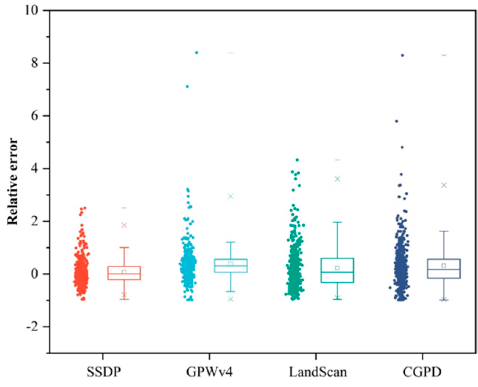
Figure 8. The scatter plot of the relative error in 500 towns from four population grids.